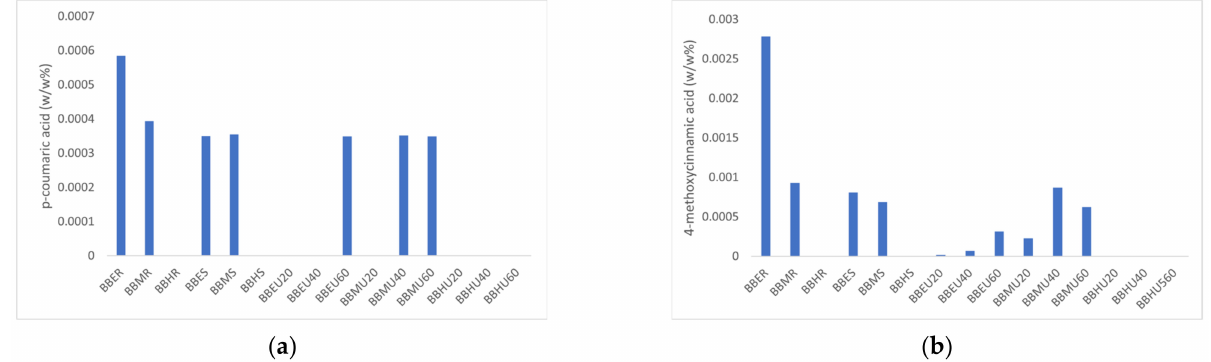
Figure 2. Content of compounds ( 4 ) and ( 5 ) in the extracts of Bambusa beecheyana . The results are reported in w / w %: ( a ) p -coumaric acid ( 4 ); ( b ) 4-methoxycinnamic acid ( 5 ).